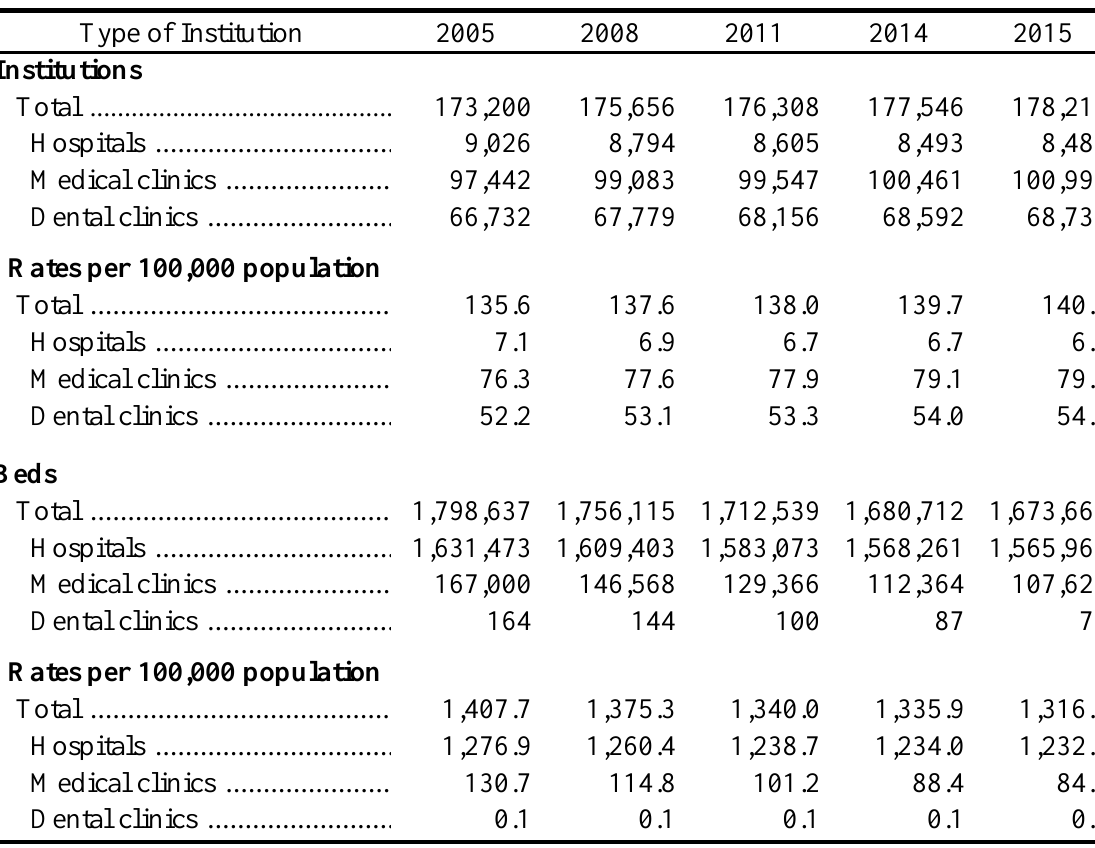
Source: Ministry of Health, Labour and